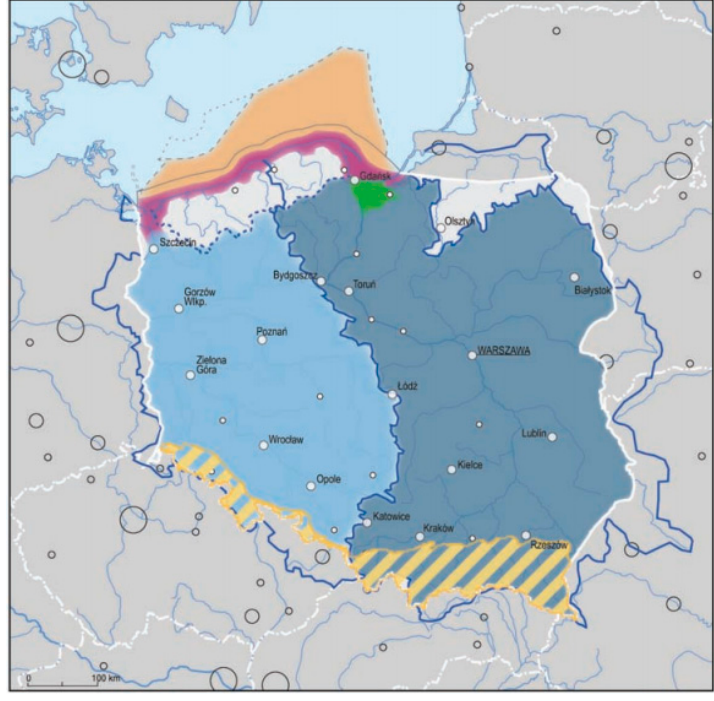
Figure 5. Functional areas of supra-regional significance. Source: [54].